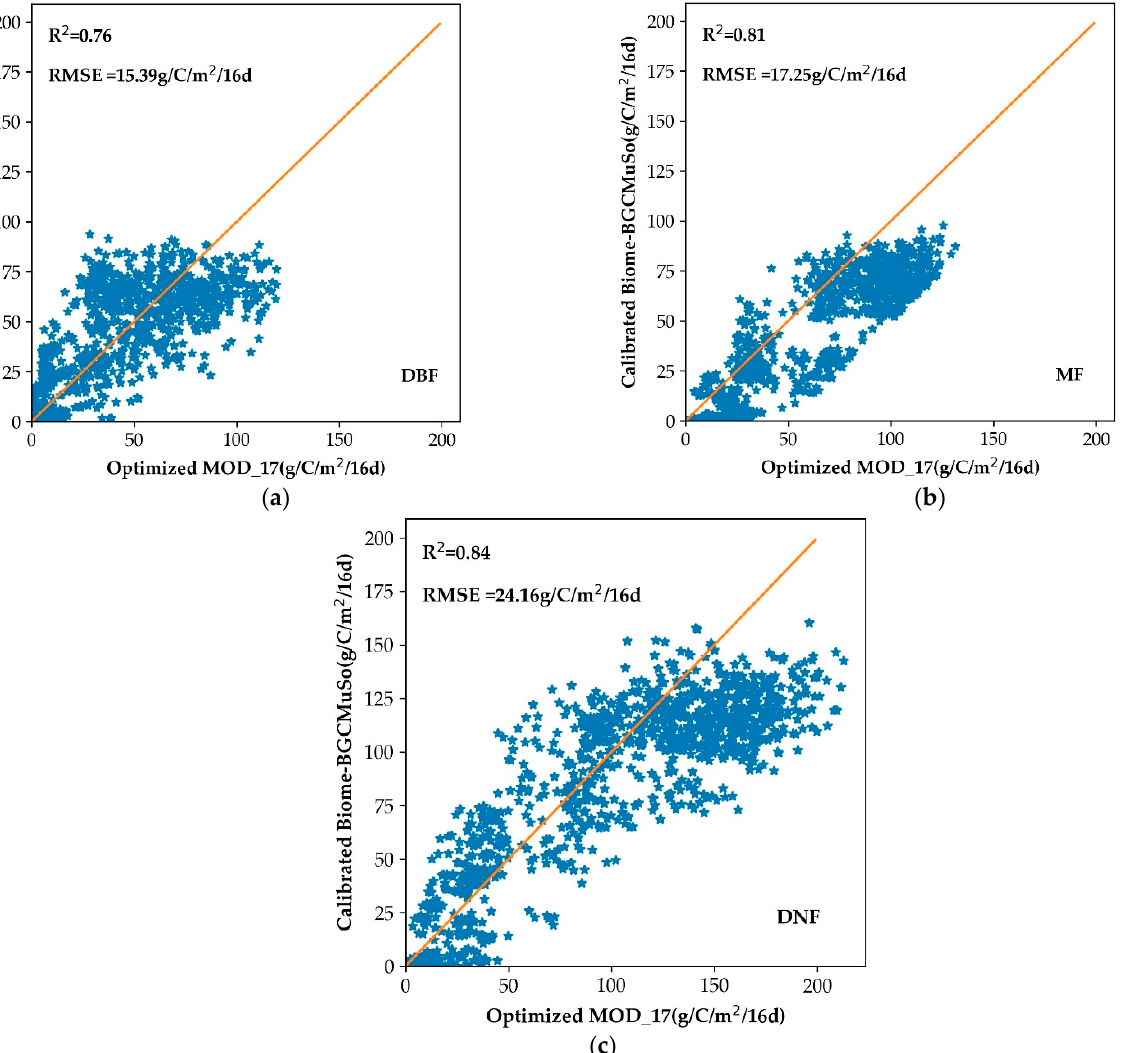
Figure 5. Comparison of 16-day GPP values fitted by the optimized MOD_17 model and the calibrated Biome-BGCMuSo model.